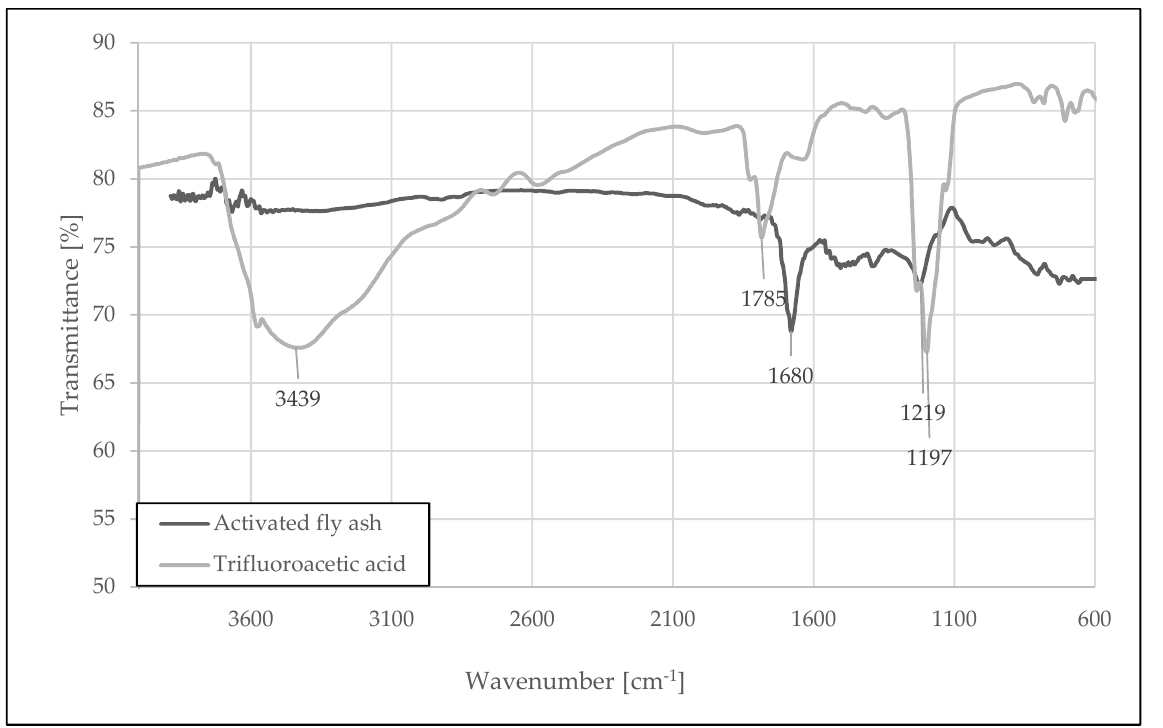
Figure 1. FT-IR spectra of the activated fly ash (black) compared to pure trifluoroacetic acid (gray).